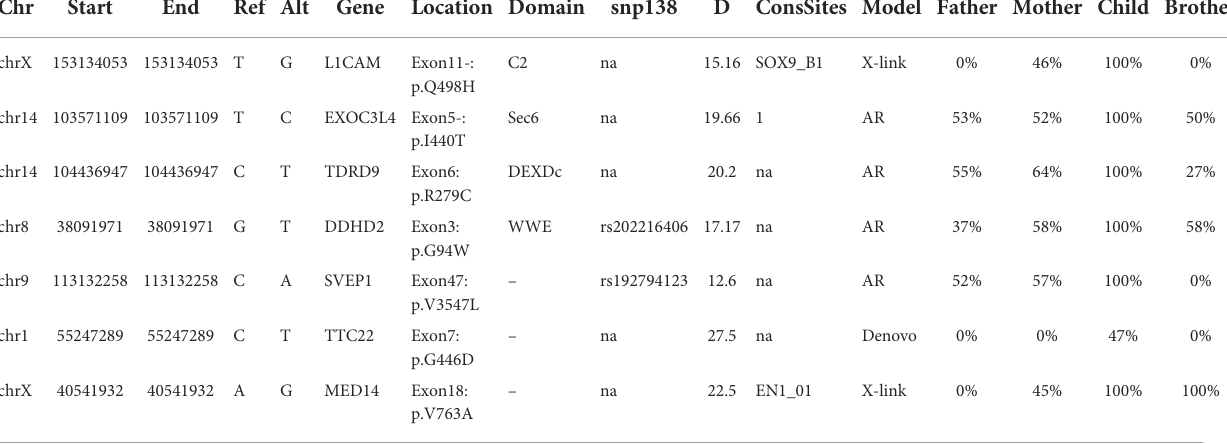
TABLE 3 List of potentially interesting variants identi fi ed by whole